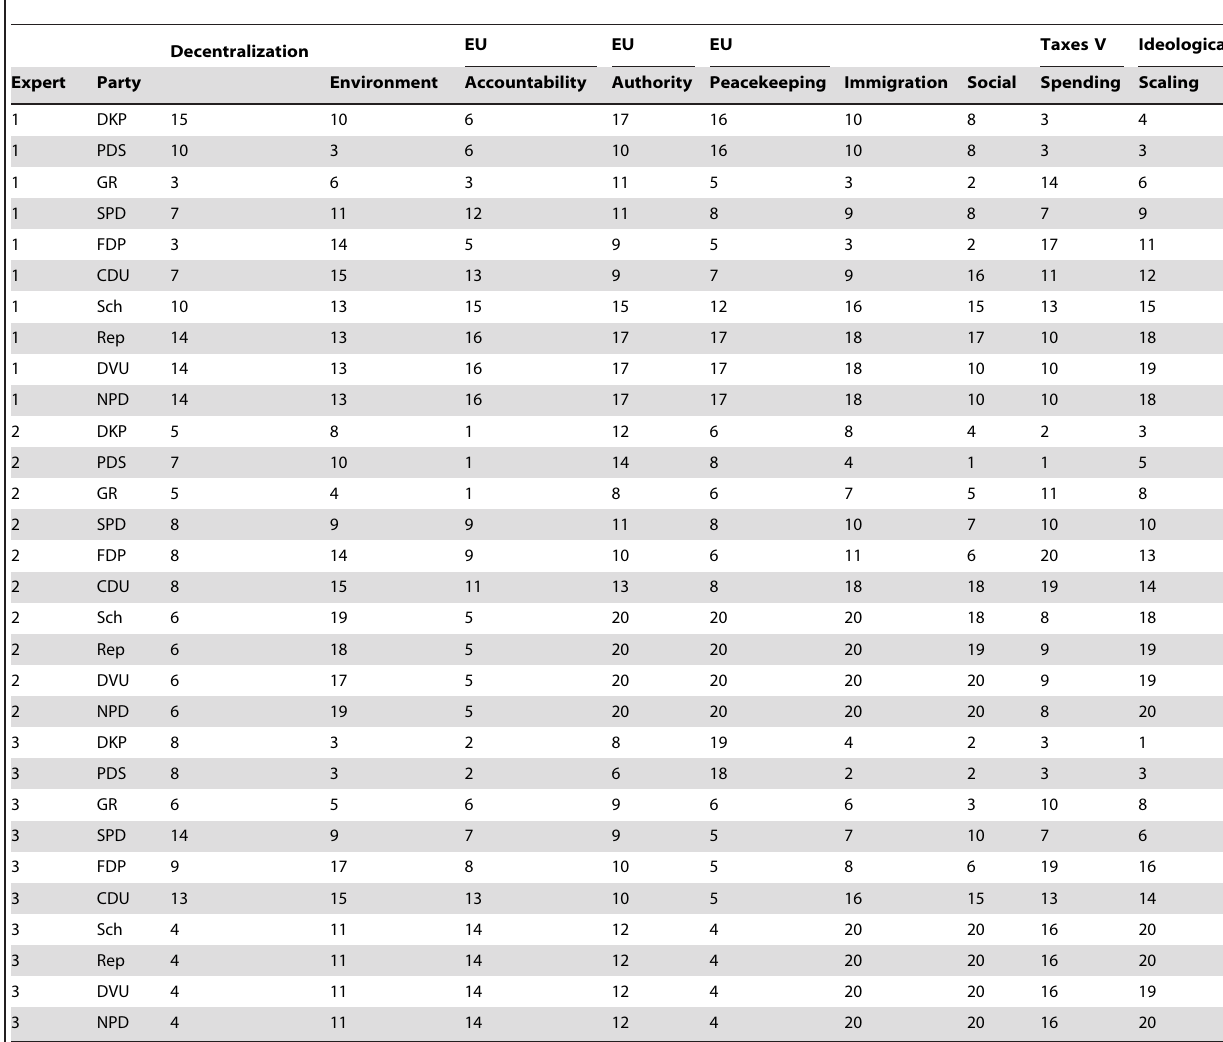
Table 2. An example of the data obtained from the first three respondents in